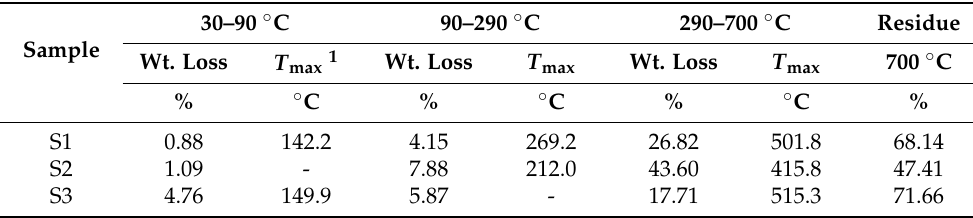
Figure 2. TGA curves of the obtained sol-gel silica samples (obtained as powders). The TGA curve obtained for silica samples shows three weight loss steps at 30–90 ◦ C, 90–290 ◦ C and 290–700 ◦ C temperature regions. Each sample shows a mass loss below 200 ◦ C that could be attributed to a loss of water and/or isopropanol. This is followed by a mass loss that occurred between 290 and 700 ◦ C. The significant mass loss above 200 ◦ C varied from sample to sample and could be assigned to the decomposition of organic groups and loosely bound Si–(OR) groups (see Table 1). It can be seen that only 17.71 wt.% weight loss was found for sample S3 below 700 ◦ C, while 26.82 and 43.6 wt.% weight loss were observed for samples S1 and S2, respectively. The third mass loss detected in the range of 290–700 ◦ C was due to the organosilicate framework degradation [30]. Table 1. The weight loss (Wt. loss) and maximum decomposition temperature ( T max ) of the sol-gel silica samples (obtained as